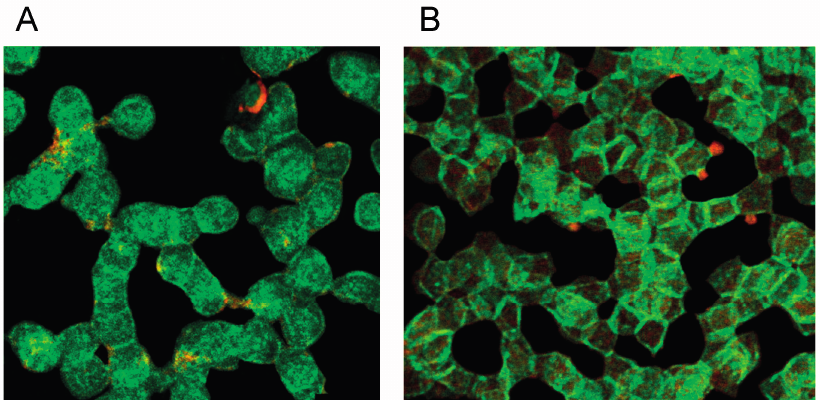
Figure 7. Spectrin reorganization in aggregated erythrocytes (reprinted from reference [20], Copyright 2013, with permission from IOSPress) ( A ) Merger of red (actin) and green (spectrin) channels of the confocal microscope after examination of spectrin–actin double stained erythrocytes suspended in plasma supplemented with Iodixanol320 (30% v / v ). ( B ) Merger of red (actin) and green (spectrin) channels of the confocal microscope after examination of spectrin–actin double stained erythrocytes suspended in a mixture of plasma and Iopromide370 (30% v / v ). (Primary magnification 1:63; zoom factor